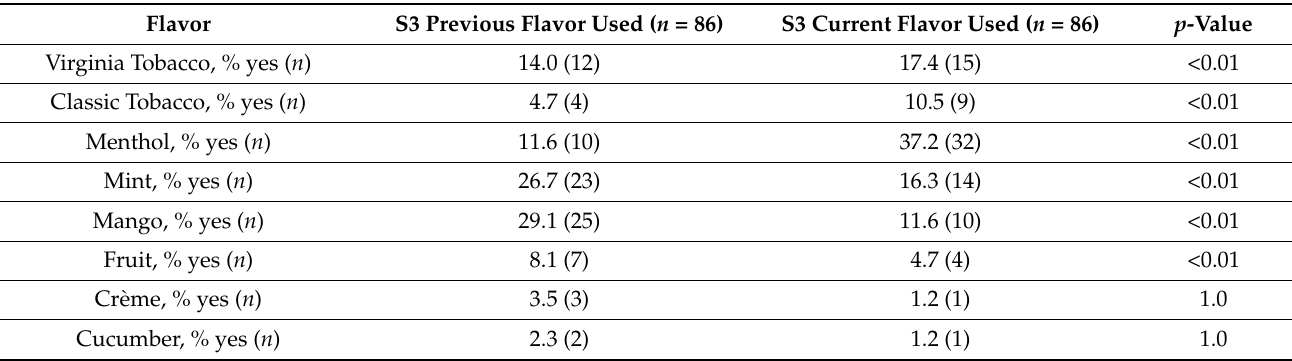
Table 1. Within-subject changes in flavor usage after FDA regulation from data collected at survey time-point 3 (S3) (April 2020).